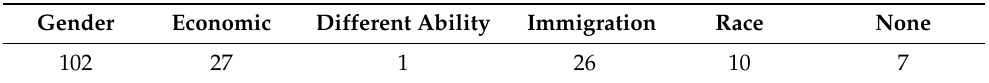
Table 5. Diversity target area prevalence. The number of initiatives found focused on each diversity area. Initiatives can have multiple diversity areas, so the total exceeds the number of initiatives. Gender Economic Different Ability